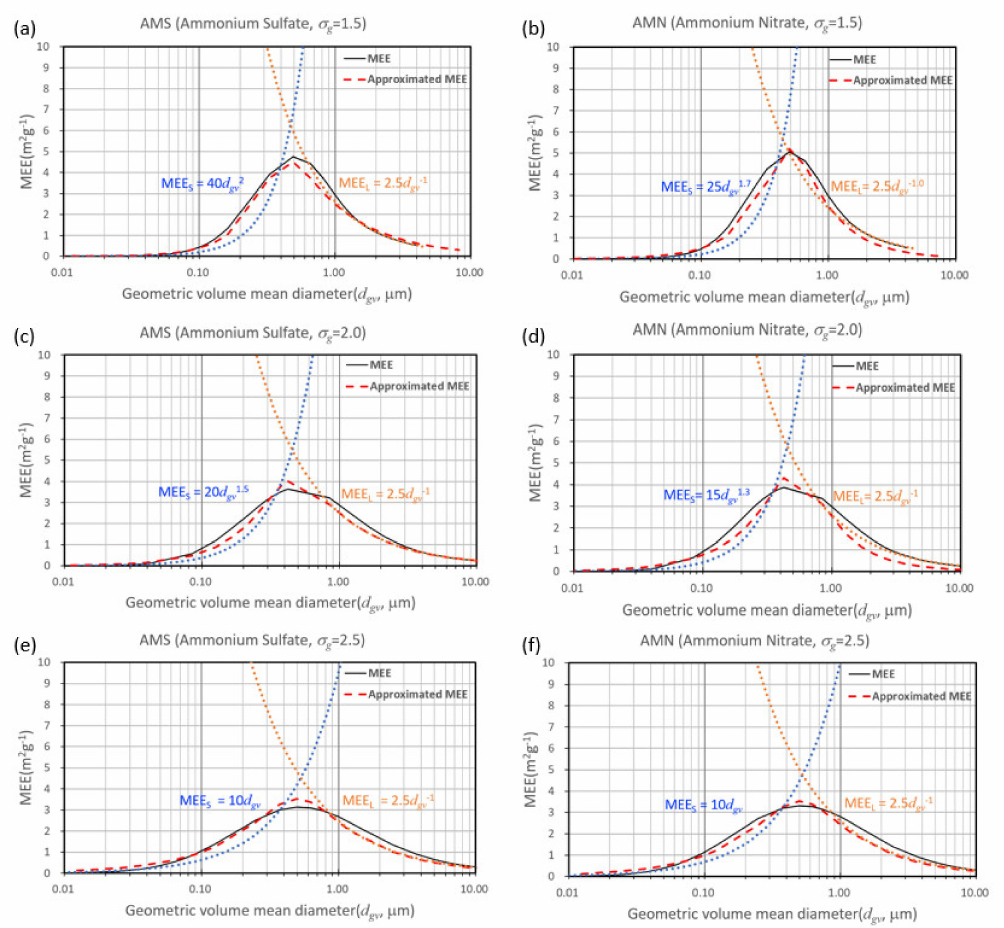
Figure 4. Comparison between the Mie-calculated mass extinction e ffi ciency (MEE, solid black lines) and the approximated mass extinction e ffi ciency (long-dashed red lines) of ammonium sulfate (AMS, left column ) and ammonium nitrate (AMN, right column ) for geometric standard deviations ( σ g ) of 1.5 ( top row ), 2.0 ( middle row ), and 2.5 ( bottom row ). The approximated mass extinction e ffi ciency in each panel is calculated based on the MEE S (dotted blue line) and the MEE L (dotted yellow line) in each panel using Equation